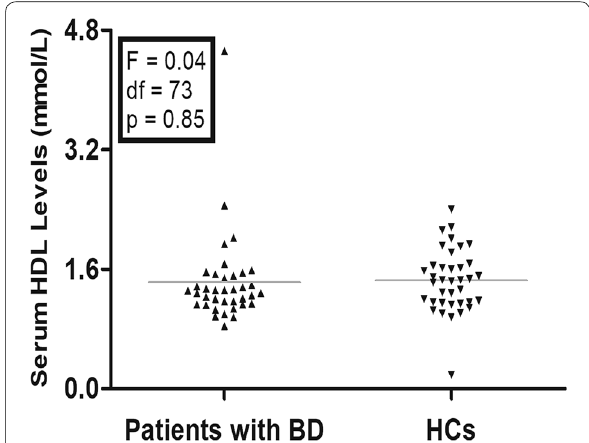
Fig. 1 There was no difference in serum HDL levels between patients with BD and HCs (1.43 0.61 mmol/l vs. 1.45 ± df 73, p 0.85) = =